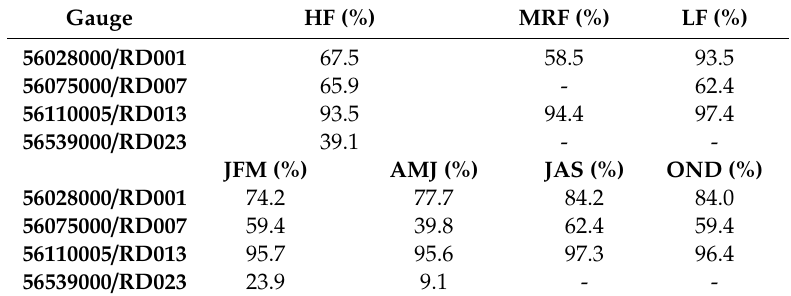
95.7 95.6 97.3 96.4 56539000 / RD023 23.9 9.1 -